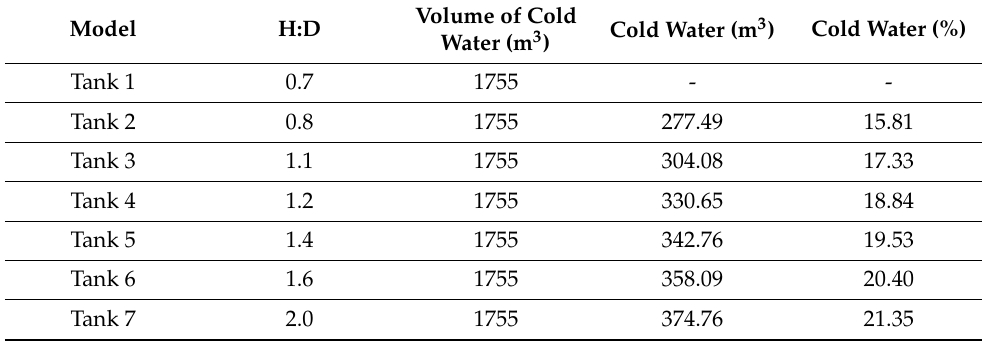
Table 4. Amount of remaining 5 °C water in the tanks after 13 h of discharge.